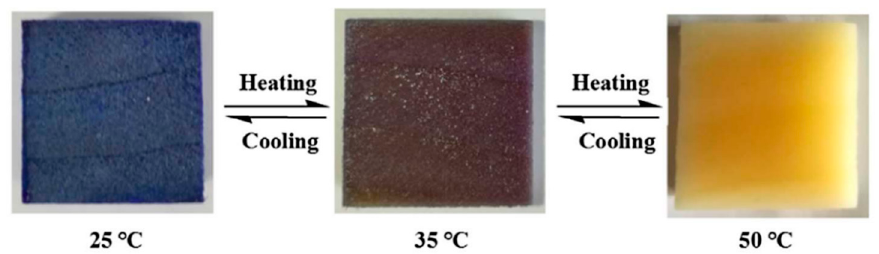
Figure 13. Color changes of composite PCMs at different temperatures [87].